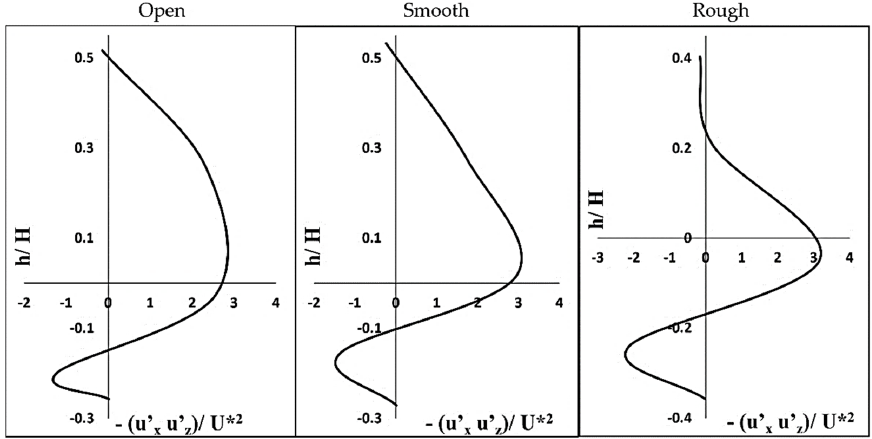
As shown in Figure 17, the Reynolds stress is zero at the scour hole bottom, and grad- ually decreases to the least negative value, and it becomes zero again in the middle of scour holes; then it increases with the distance from the scour hole bottom, afterward it decreases toward the water surface. Inside the scour hole, the distribution of the Reynolds stress has a parabolic shape. Outside the scour hole, the value of the Reynolds stress becomes positive, and it reached its maximum slightly above the initial level of the sand bed (flume bed). Then it reduces again toward the flow surface and became negative close to the surface, creating a convex shape distribution (Figure 17).